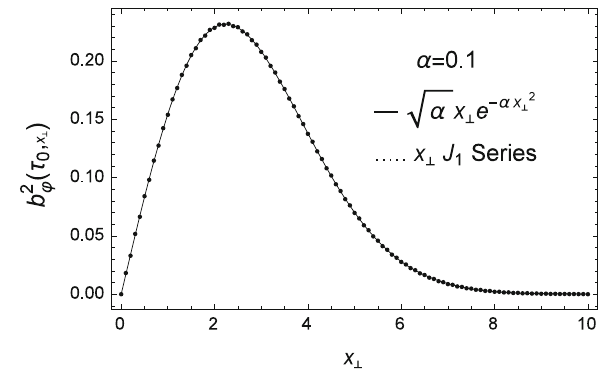
Fig. 2 A comparison between the approximated b 2 φ in Bessel series (dotted curve) and the assumed external magnetic field (solid curve) with n = − 1